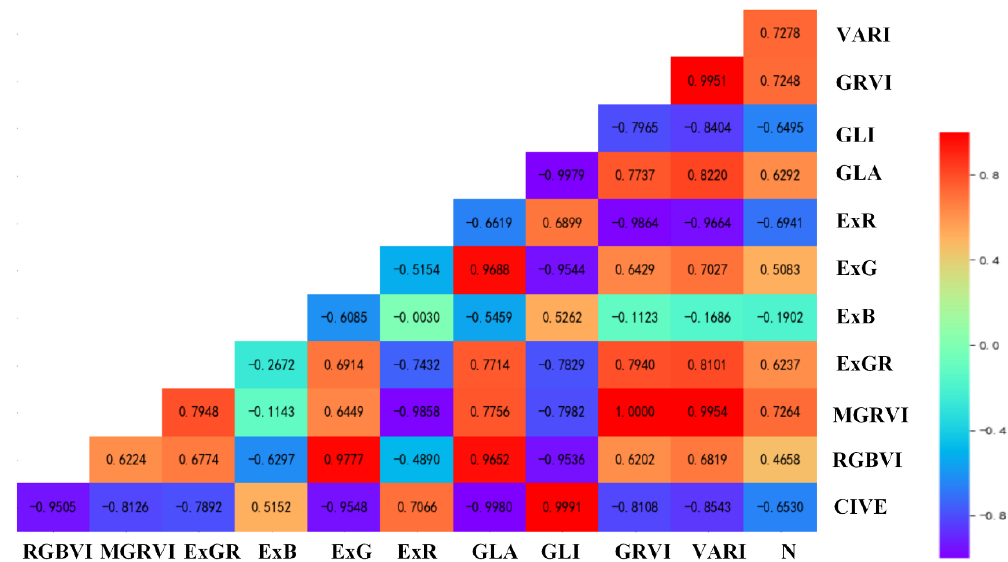
Figure 2. Matrix of the correlation coe ffi cient between the N content and individual vegetation indices (VIs).